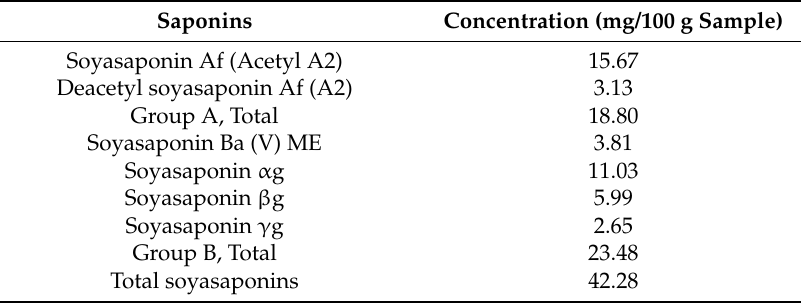
Table 2. Saponin content in bean raw cultivar “Negro San